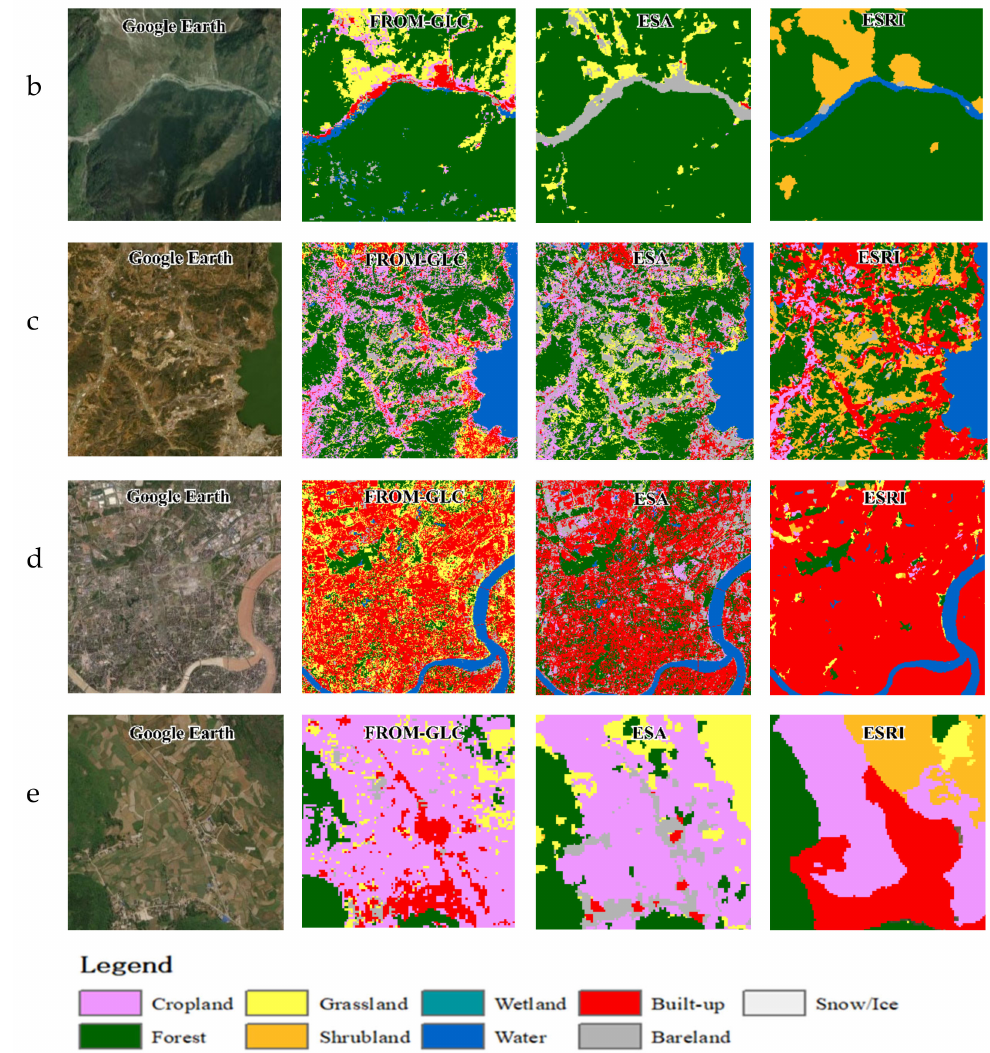
Figure 9. Comparison of three land cover products with Google Earth image: ( a ) XiZang, ( b ) SiChuan, ( c ) YunNan, ( d ) ChongQing, and ( e )